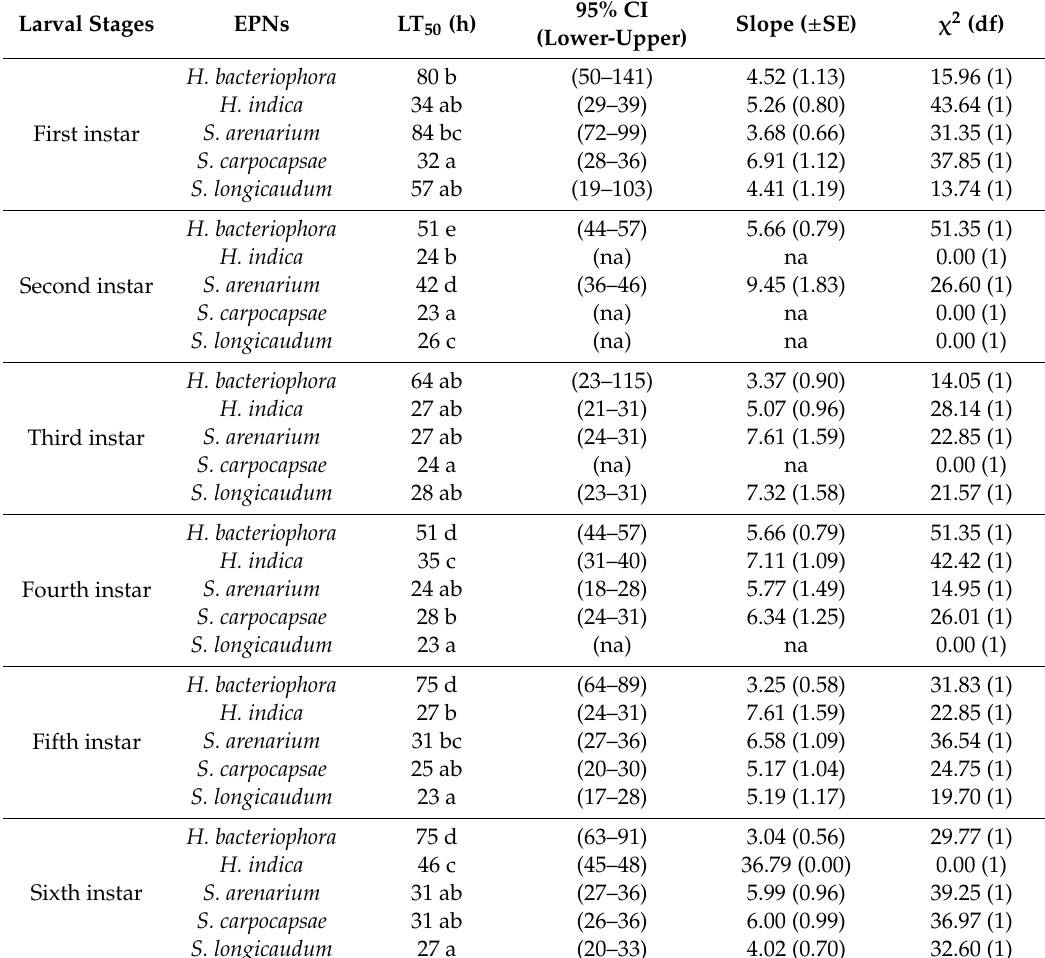
Table 2. Comparison of median lethal times (LT 50s ) for entomopathogenic nematode species (EPNs) against the various developmental stages of Spodoptera frugiperda